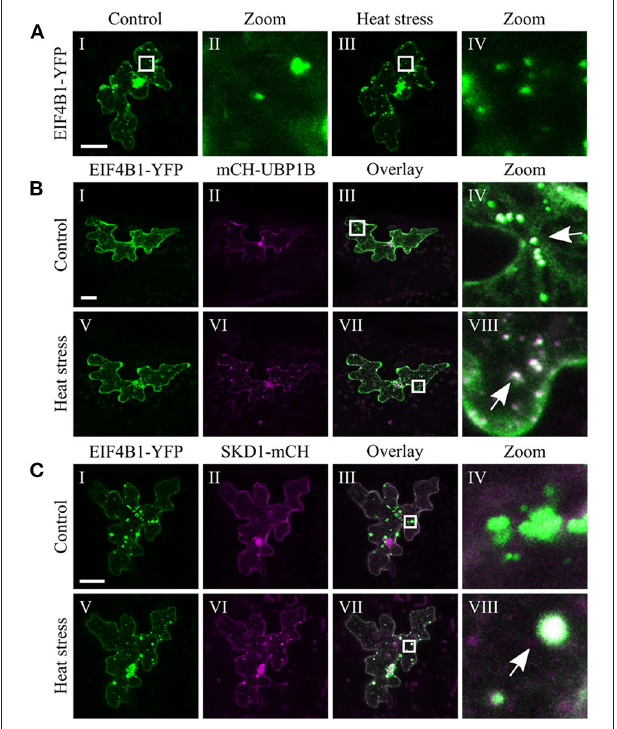
FIGURE 7 | Subcellular localization of EIF4B1 before and after heat stress. Representative images of CLSM stacks (maximum projections) of leaf epidermal cells single or double transformed with constructs overexpressing ( 35S promoter) EIF4B1. The results are summarized in Table 3 . The same cells were imaged before and after heat stress. Co-localizing structures are indicated by arrow heads. Scale bar = 20 µ m. EIF4B1-YFP (A) alone, (B) with mCH-UBP1B, (C) with